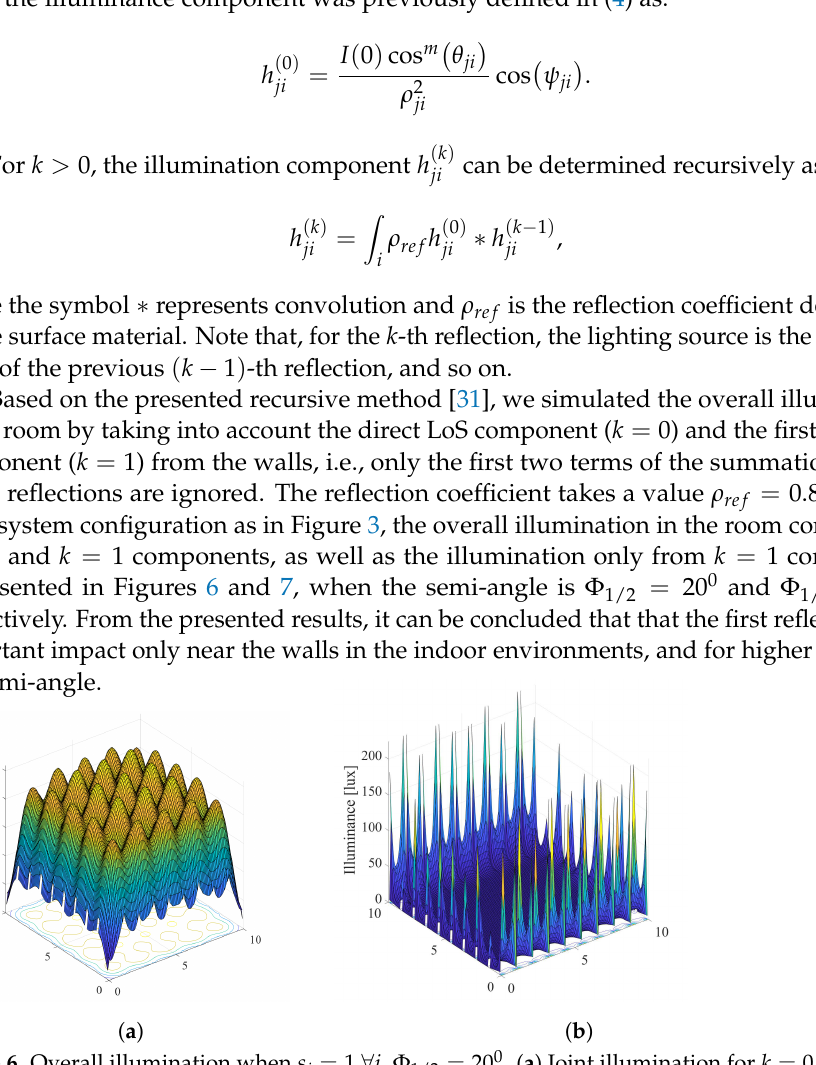
Figure 6. Overall illumination when s i = 1 ∀ i , Φ 1/2 = 20 0 . ( a ) Joint illumination for k = 0 and k = 1. ( b ) Illumination only for k =